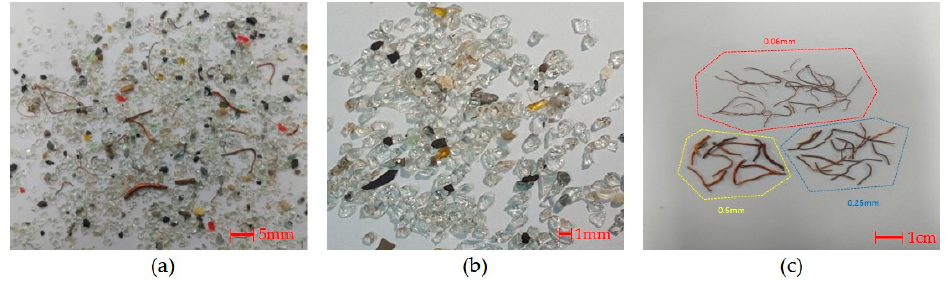
Figure 3. Automobile-shredder-residue (ASR) samples used in this study: ( a ) ASR; ( b ) glass; ( c ) copper wire.